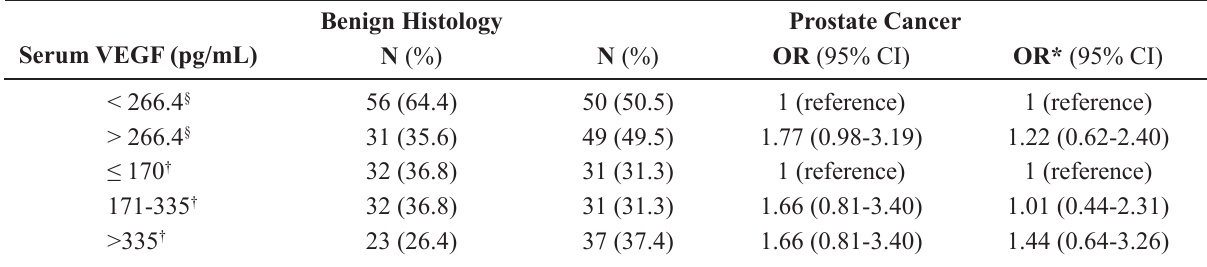
Table 3 – Multivariate logistic analysis of the association of vascular endothelial growth factor (VEGF) with prostate